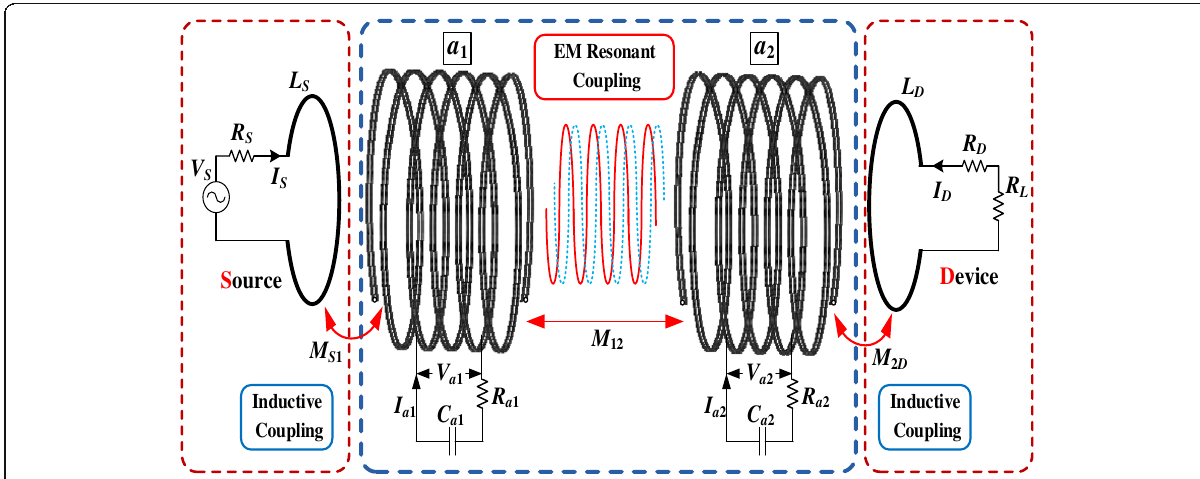
Fig. 2 Directly field-circuit model of a MRC-WPT system. The analysis of the coupling principle of the field-circuit is shown in Fig. 2. The source coil and device coil are coupled with the resonant coils through inductive coupling, and the resonant coils perform power transmission through EM resonant coupling